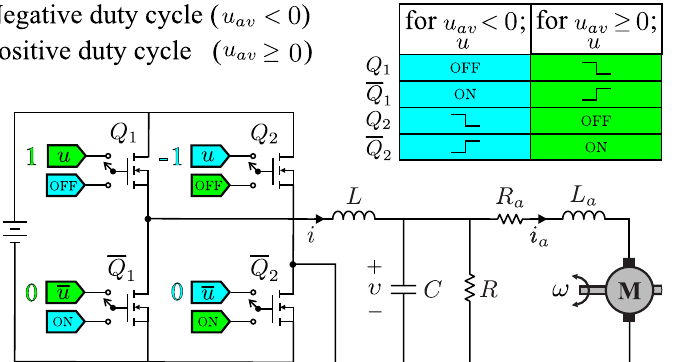
Figure 2. Full-bridge Buck inverter–DC motor system and clock signals u associated with Q 1 , Q 1 , Q 2 , and Q 2 , for the negative duty cycle ( u av < 0 ) and for the positive duty cycle ( u av ≥ 0 )